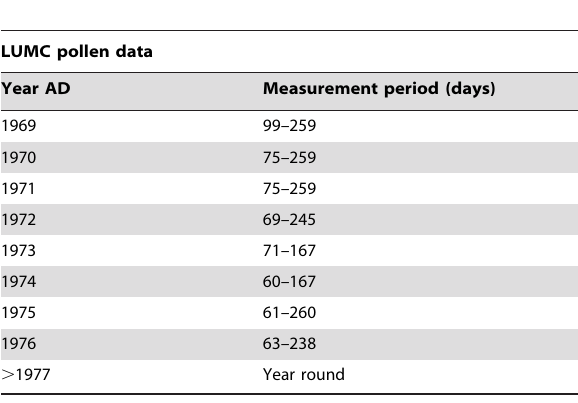
Table 1. Availability of LUMC (day of the year, January 1 st = day